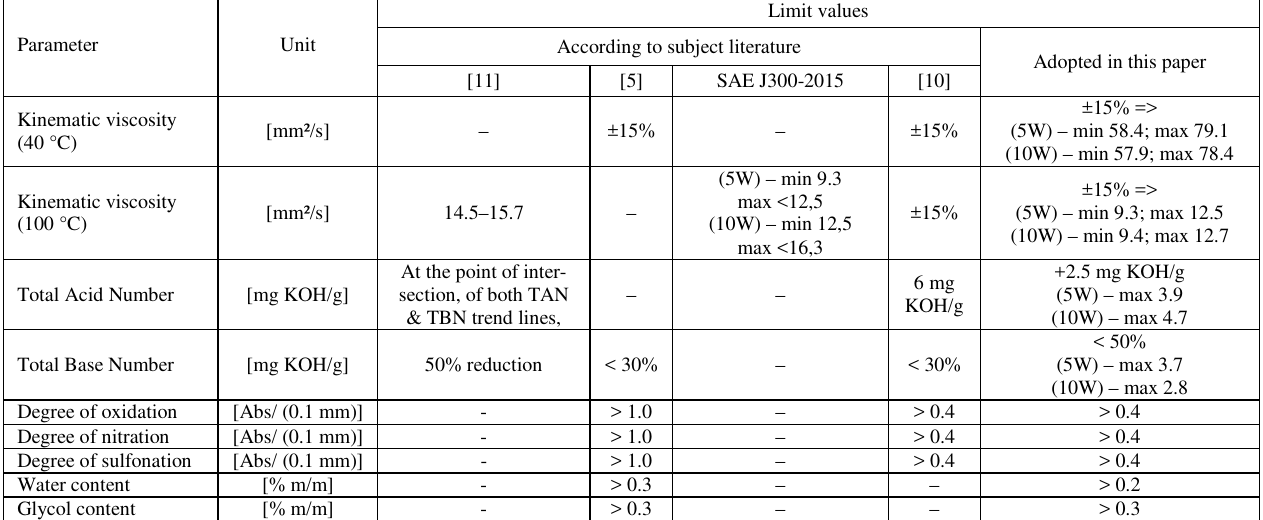
Table 3. Details related to limit